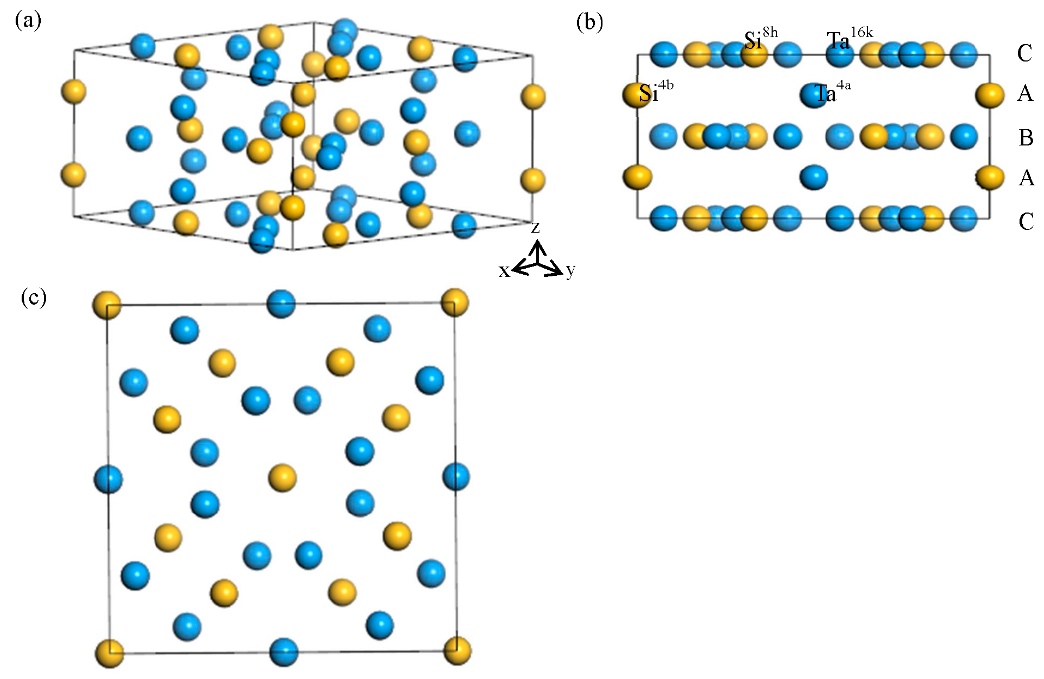
Figure 1. The crystal structure of D8 m Ta 5 Si 3 : ( a ) 3D model; ( b ) side view; ( c ) top view. Ta atoms ( blue balls) and Si atoms ( yellow balls) have two symmetrically non-equivalent positions. The elements on the close-packed planes (represented by the B-layer and C-layer) are termed Ta 16k and Si 8h , and those on the less close-packed planes (represented by the A-layer) are termed Ta 4a and Si 4b